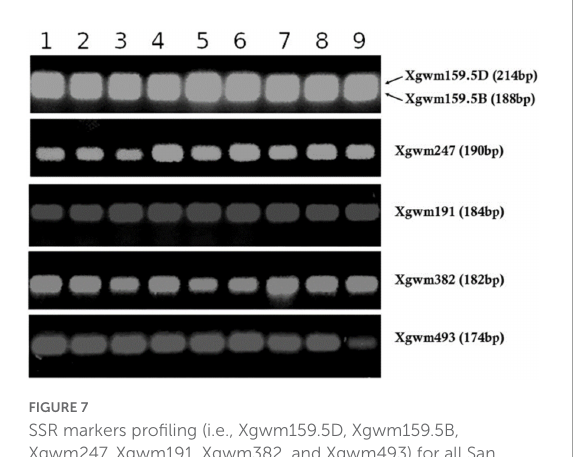
FIGURE7 SSR markers profiling (i.e., Xgwm159.5D, Xgwm159.5B, Xgwm247, Xgwm191, Xgwm382, and Xgwm493) for all San Pastore grain samples under analysis. The number reported above corresponds to the sample number exposed in Table 1 .